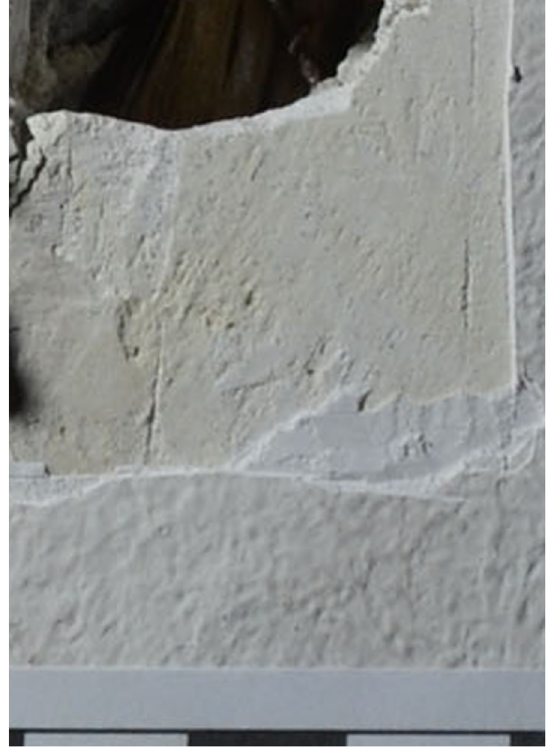
Fig. 20 Josef Frank und Oskar Wlach, Villa Beer in Wien-Hietzing (1930), music gallery, ceiling, probe 2017 in the area of the lamp, original yellowish white paint (see Fig. 19) (Source: HABEAS 2017)